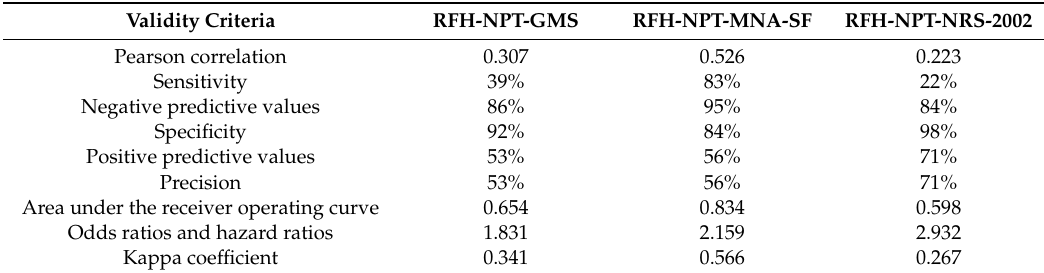
Table 3. Overview of criterion validity expressed by area under the receiver operating curve, odds ratios and hazard ratios, sensitivity, negative predictive values specificity, positive predictive values, precision, Pearson correlation and Kappa coe ffi cient.